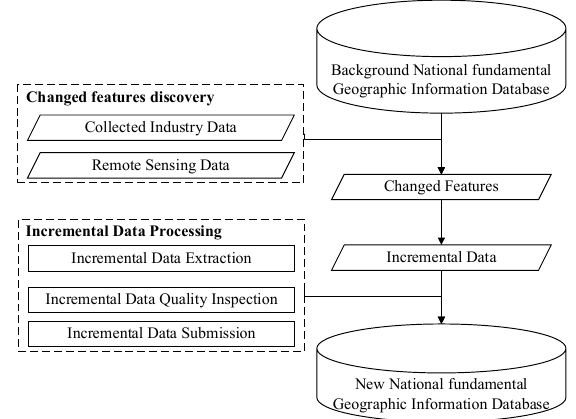
Figure 8 . Flow chart of national fundamental